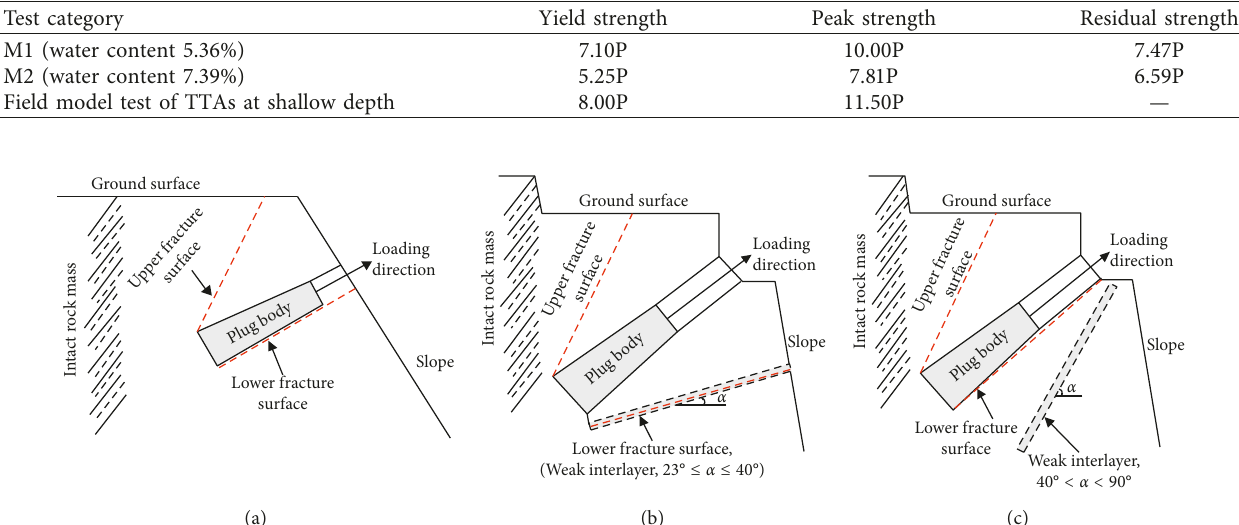
Figure 13: The failure modes of TTA under complex geological conditions [36, 38, 39, 65]: (a) shallow TTA in soft rock, (b) TTA with an underlying weak interlayer with a small dip angle, and (c) TTA with an underlying weak interlayer with a large dip